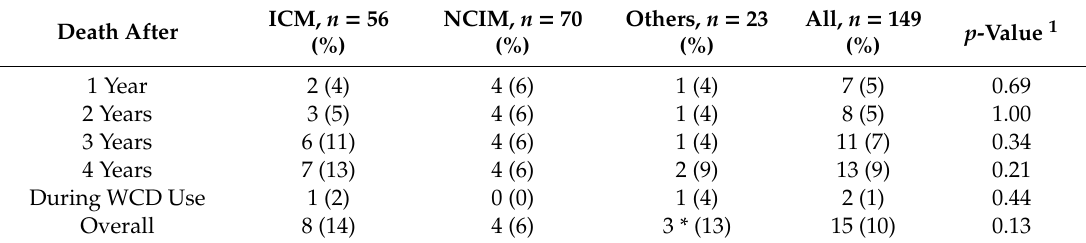
Table 5. 4-year mortality by disease etiology during median follow-up (median 34: IQR 24–46